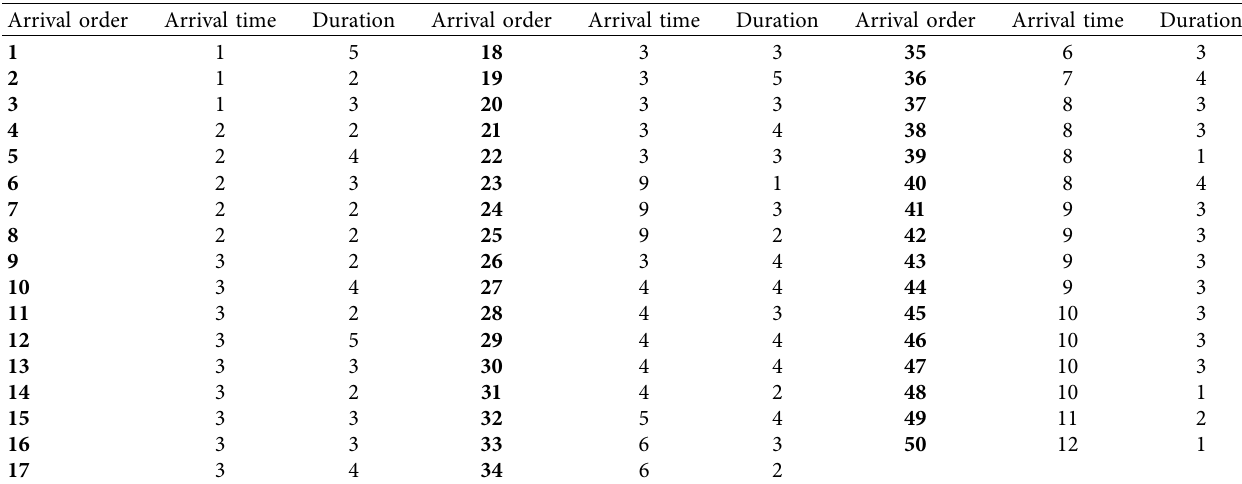
Table 3: Parking demand of travelers under the “arrival priority”